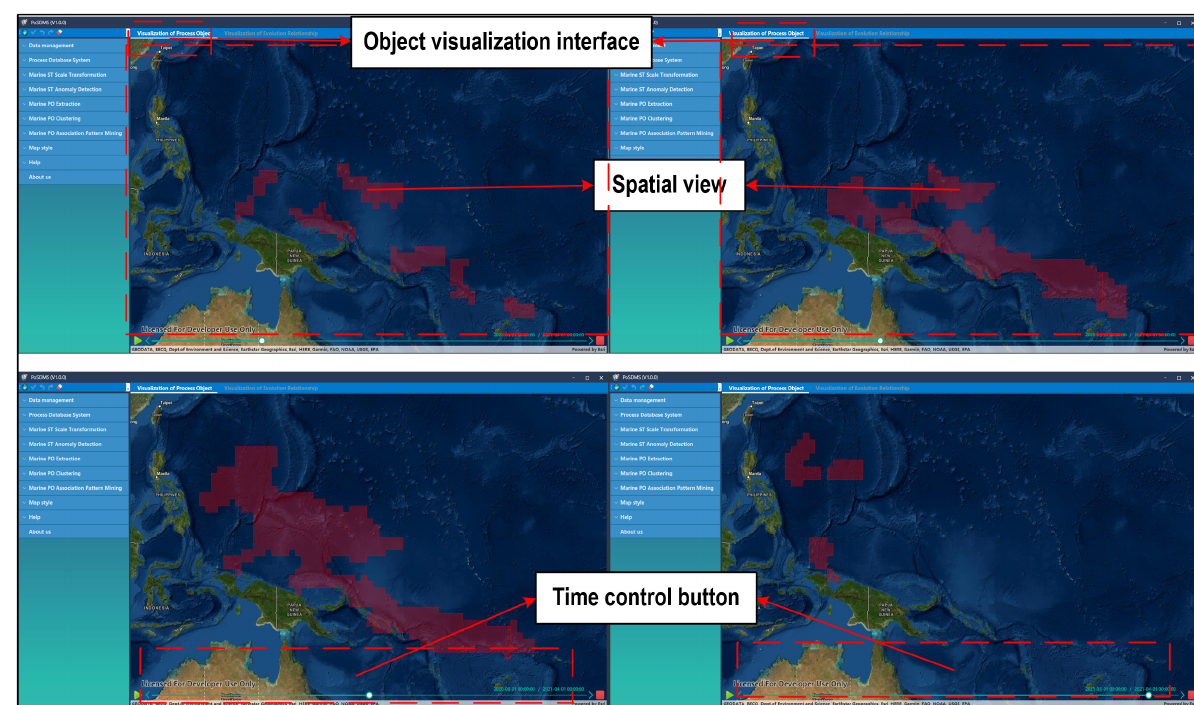
Figure 11. Spatial distribution of a specified process object of SSTA at different time snapshots.